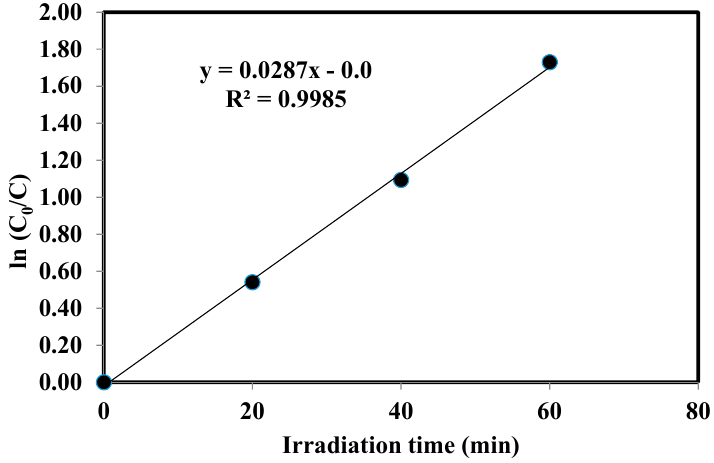
2 NPs under optimal conditions. Catalysts 2016 , 6 , 163